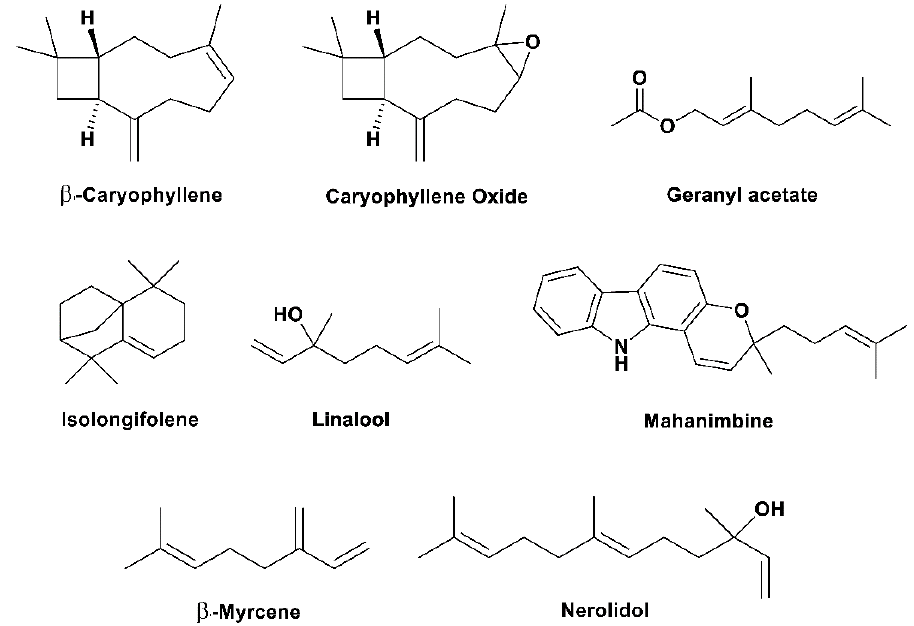
Figure 1. Biologically active natural products from Murraya koenigii against neurodegenerative diseases.